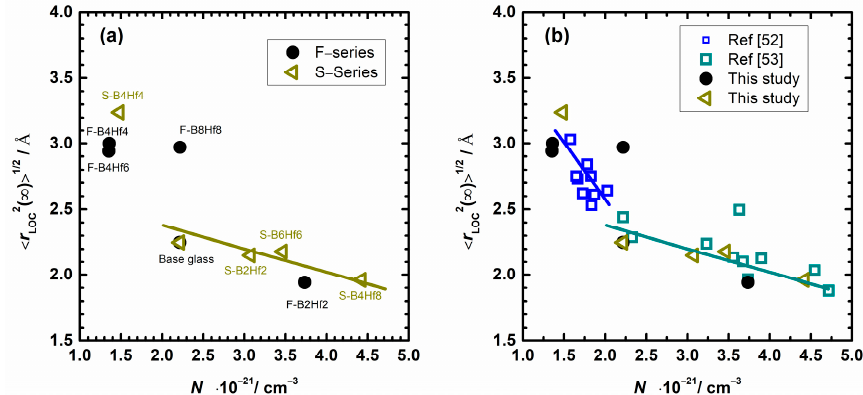
Figure 9. ( a ) The spatial extent of localized motions of polarons, < r LOC2 ( ∞ )> 1/2 , as a function of the number density of polarons for studied F and S glass series and ( b ) Values for similar iron phosphate glass (IPG)-based glasses from reference [52,53] are also presented. The lines are drawn as guides for the eye.